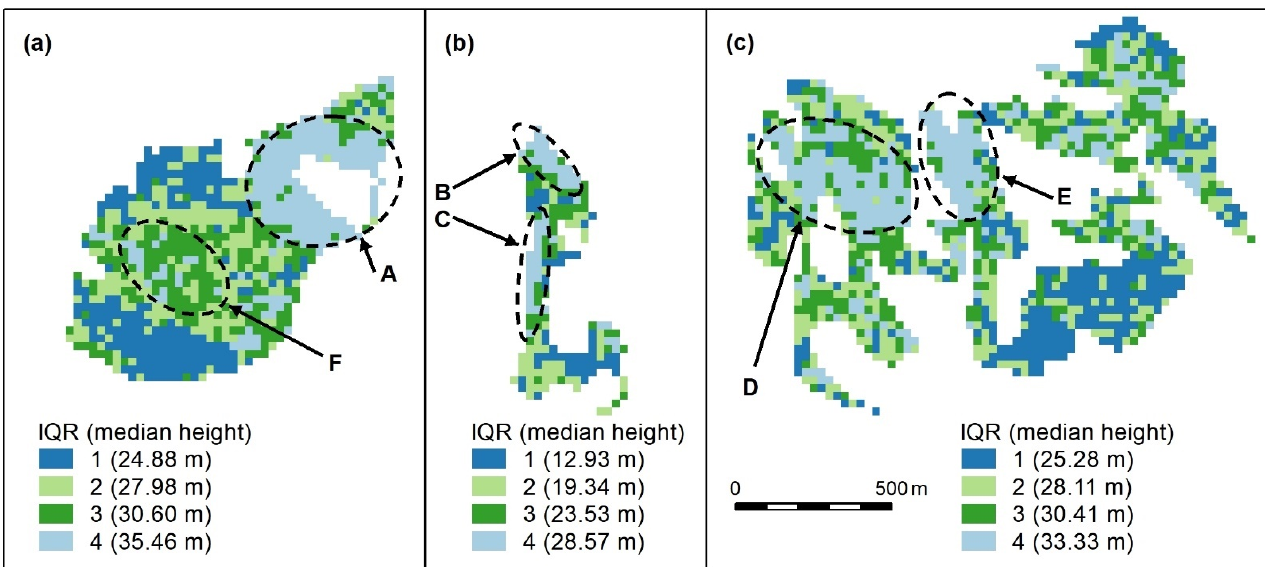
Figure A1. Compact ( a ), linear ( b ), and complex ( c ) polygon groups, showing the interquartile ranges (IQR) and interquartile median canopy heights within each group. We used this map to assess and compare the clustering algorithm outputs which follow. Spatial patterns are evident, for, e.g., patches of the highest canopy (A–E, light blue) and an area of moderate height (F, dark green), surrounded by a canopy with a slightly lower height (light green). The height appears more randomly distributed in other areas, except for lower canopy height areas (dark blue). All maps use the same scale.